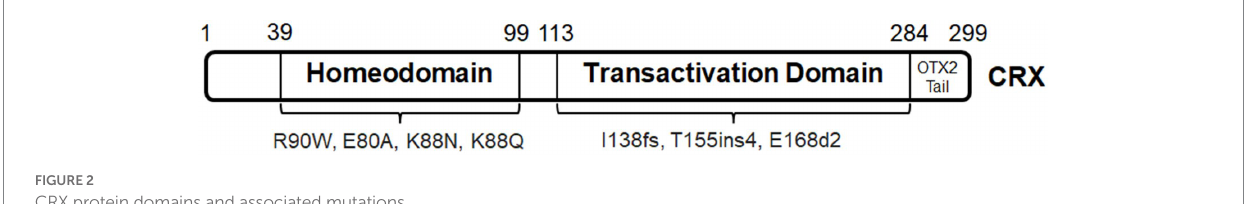
FIGURE 2 CRX protein domains and associated